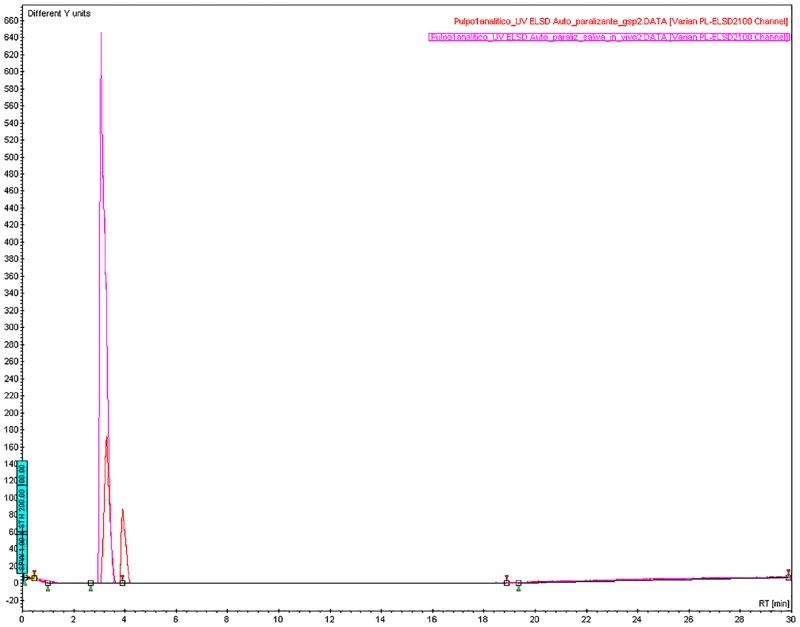
Comparison of paralyzing fractions of Octopus maya saliva.The HPLC chromatogram from C18 reverse-phase separation of the paralyzing fraction from posterior salivary glands (red) provided by fishers matched the paralyzing fraction from saliva in vivo (pink). Detection: ELSD, neb. temp = 40°C, evap. temp = 80°C, flow 1 mL/min.